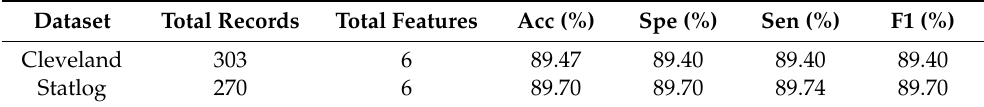
Table 4. Performance of proposed model with feature